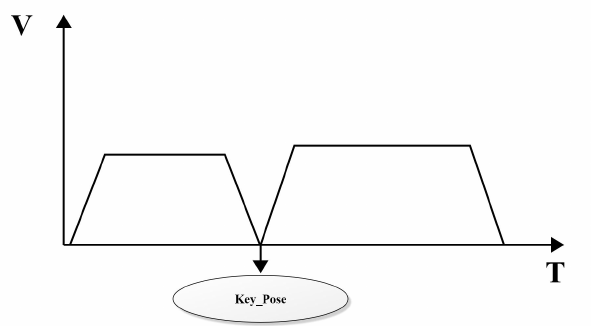
Figure 4. Continuous motion interrupt diagram.